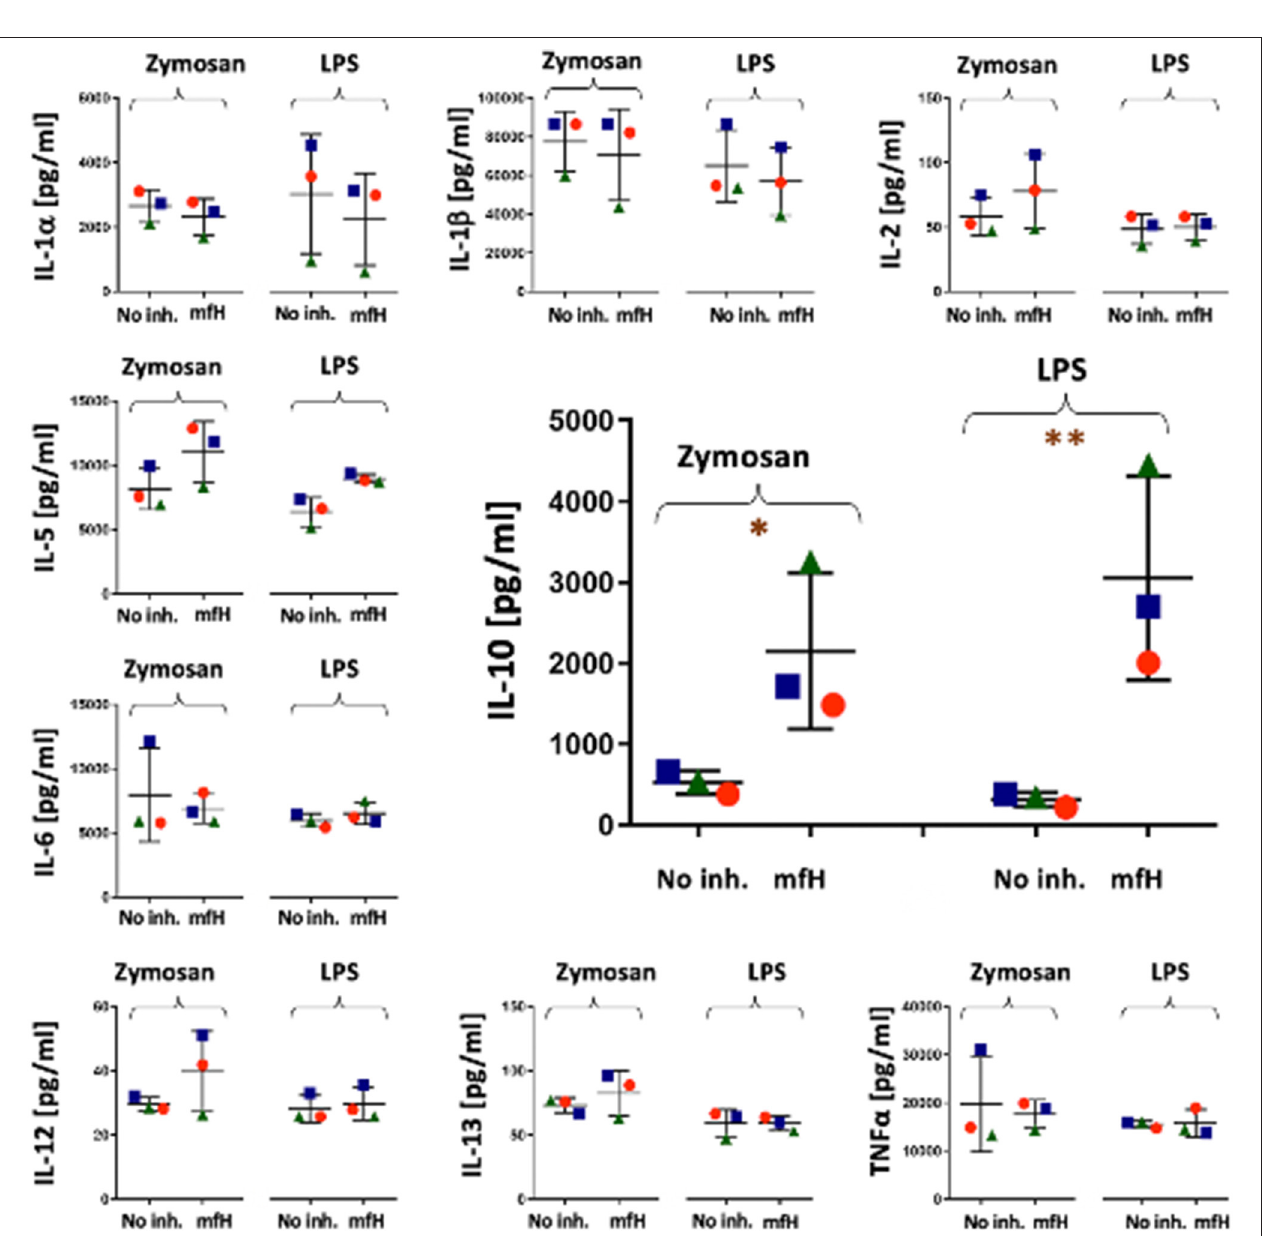
FIGURE 5 | Cytokine levels in PBMC culture supernatants after 6h activation with zymosan and LPS in the presence and absence of mfH. Each panel presents data for different cytokines (Y axis labels). The colored spheres, triangles and rectangles specify the three different blood donors. The significant stimulatory effect of mfH on IL-10 is enlarged in the middle of the figure. *( P < 0.05), **( P < 0.01) imply significant enhancement compared to control (No inh.) by pairwise two-tailed T